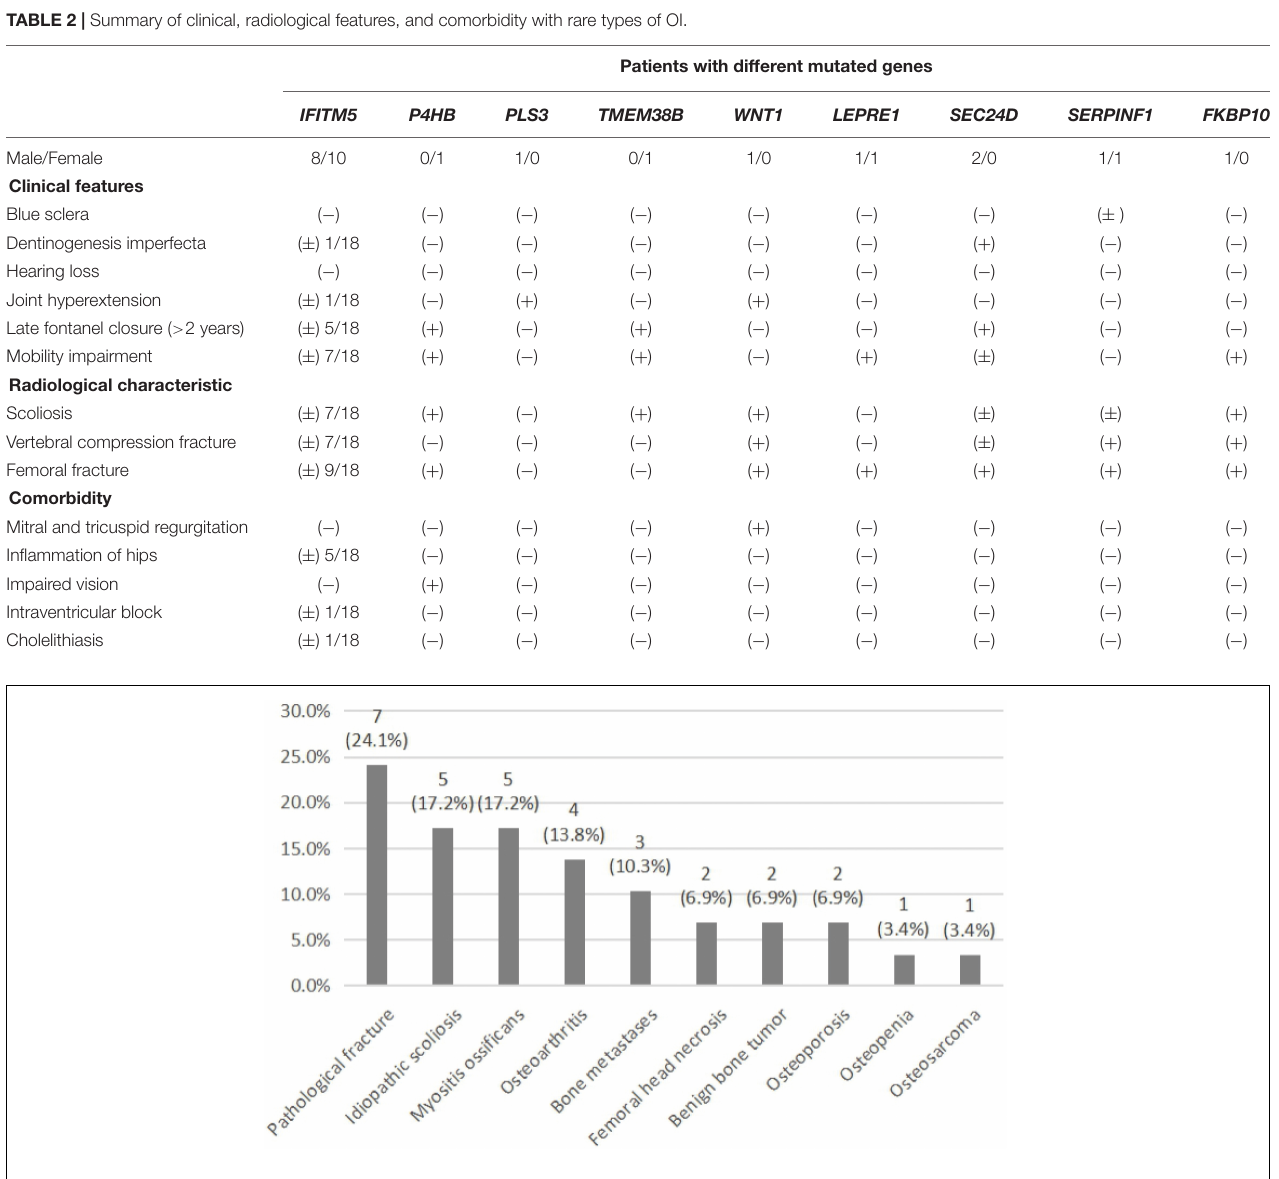
FIGURE 1 | The misdiagnosis condition in rare types of